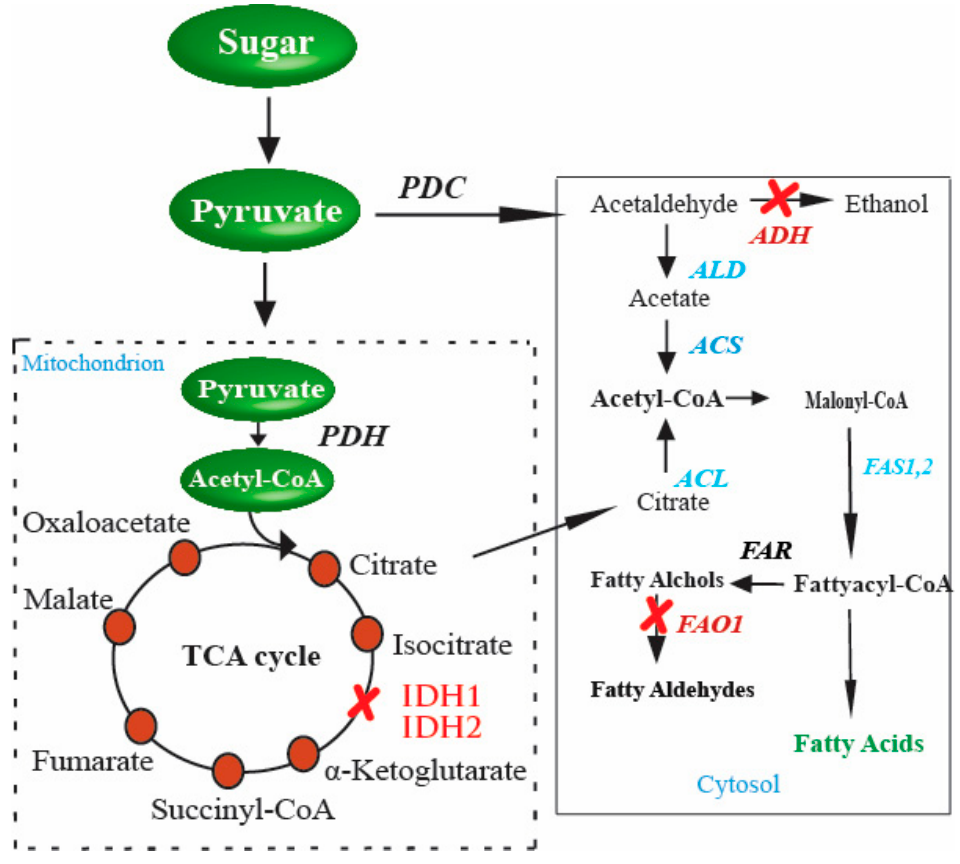
Figure 2. Genetic perturbations in S. cerevisiae for enhanced production of FAs. These genetic perturbations result in higher levels of FAs in S. cerevisiae . Once there is an excess of citrate in the cytosol, the gene responsible for converting citrate to acetyl-CoA, ACL (shown in red in the cytosol), is inserted into S. cerevisiae . These genetic perturbations result in higher levels of FAs in yeast. The strengthened steps involved in enhanced FA production are indicated in blue, and the blocked steps are indicated in red